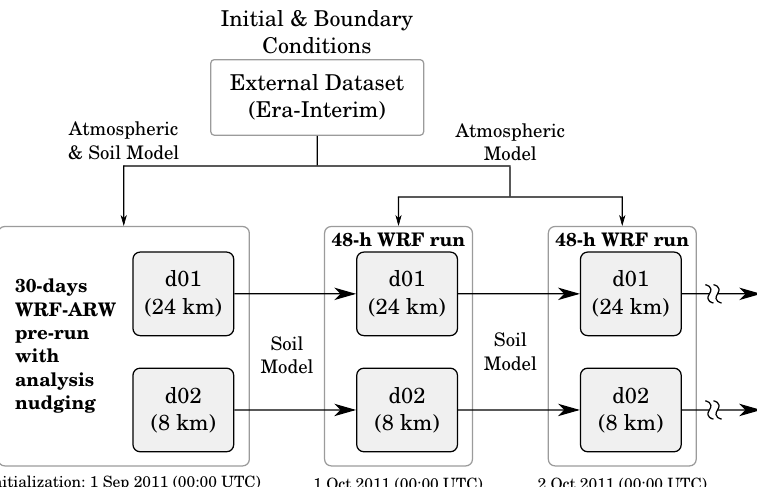
Figure 6. Schematic diagram of the sequence of daily WRF-ARW simulations conducted to reconstruct a complete time series of relevant variables during October 2011. Initial and boundary conditions for atmospheric fields were defined from ERA-Interim dataset. The land-surface model for the first run of the sequence was initialised from a soil spin-up run with analysis nudging. The subsequent runs were initialised from the precedent 24 h forecast in the